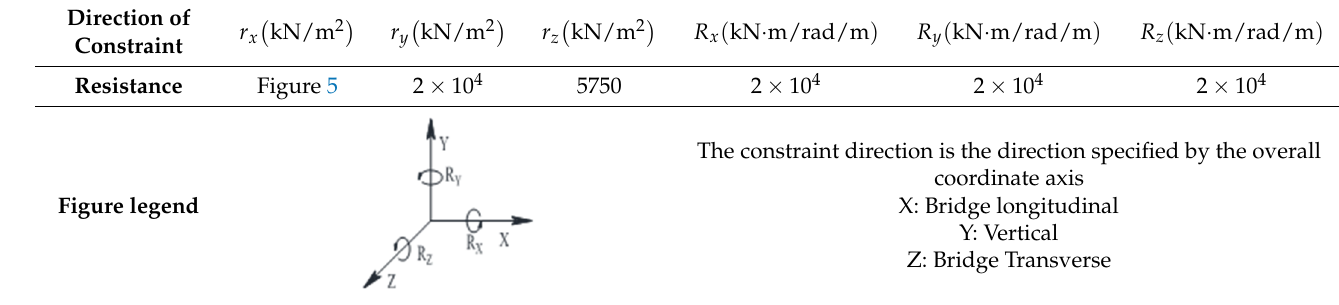
Table 1. The values of the resistance parameters of the ballast bed.